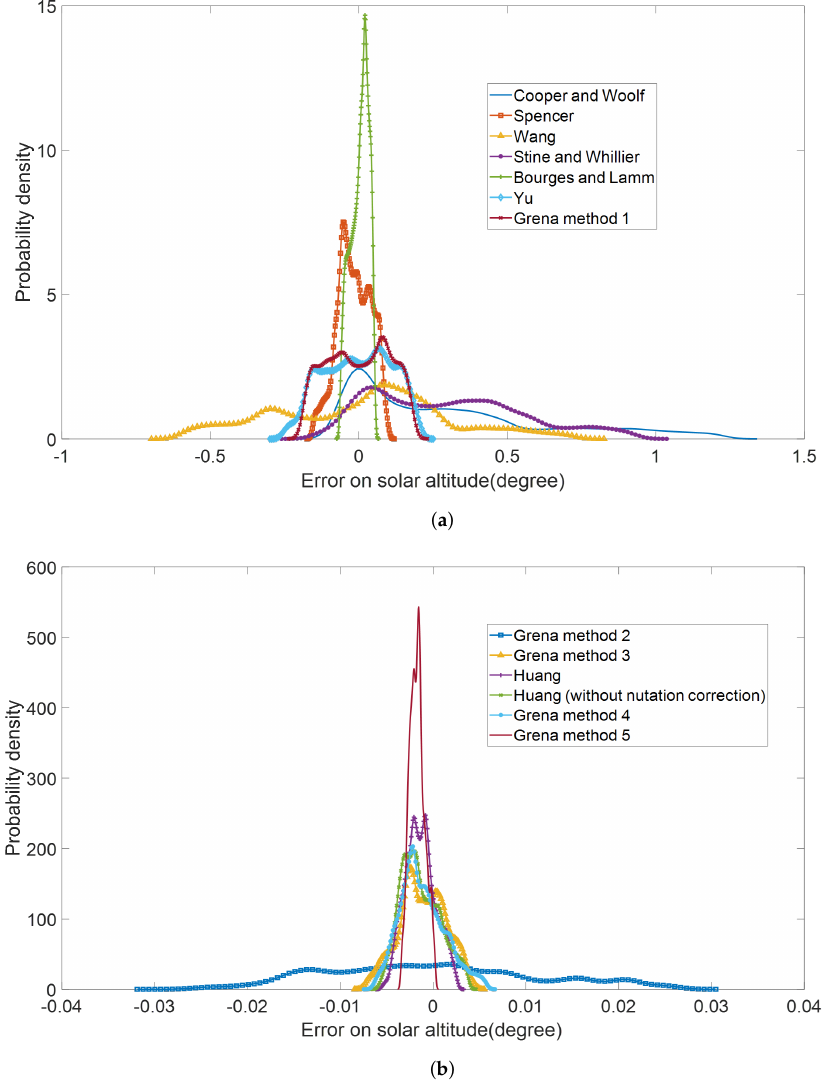
Figure 2. The probability density distribution of the calculation error of solar altitude; ( a ) Solar position empirical algorithm. ( b ) Solar position complex